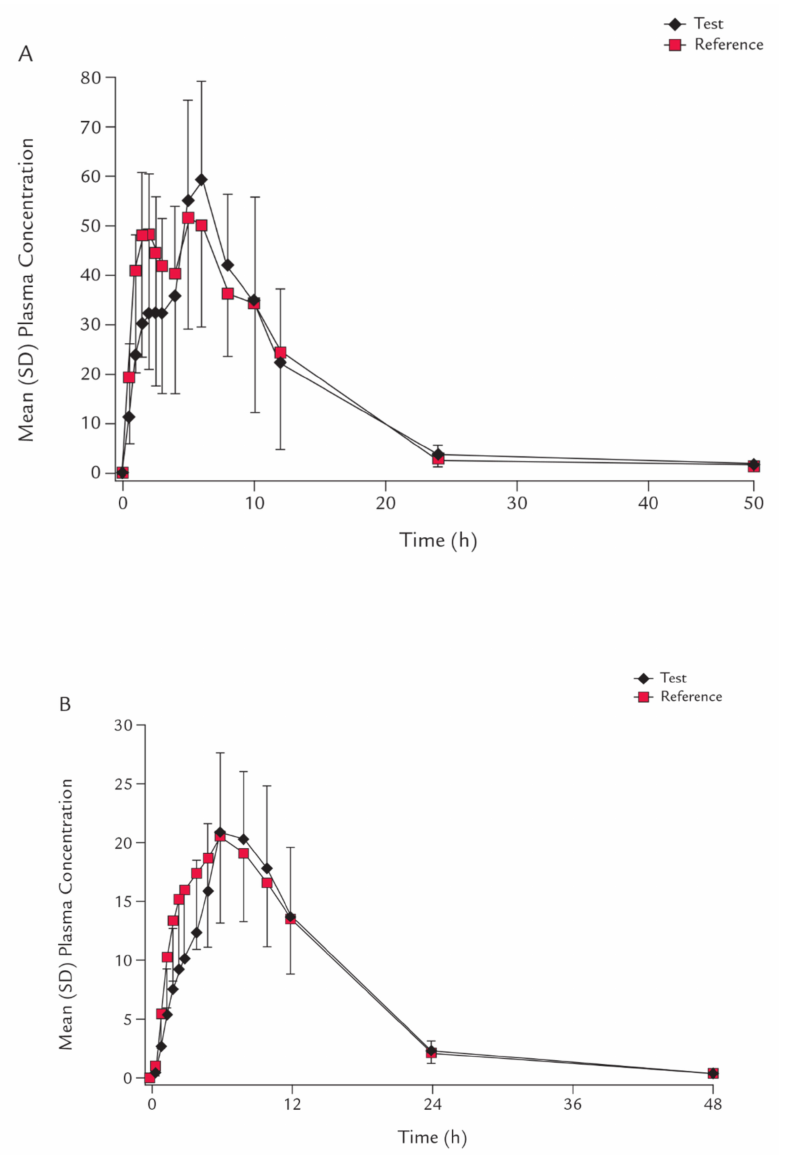
Figure 3. The time plasma concentration profile of empagliflozin under fasting ( A ) and fed ( B ) condition states in